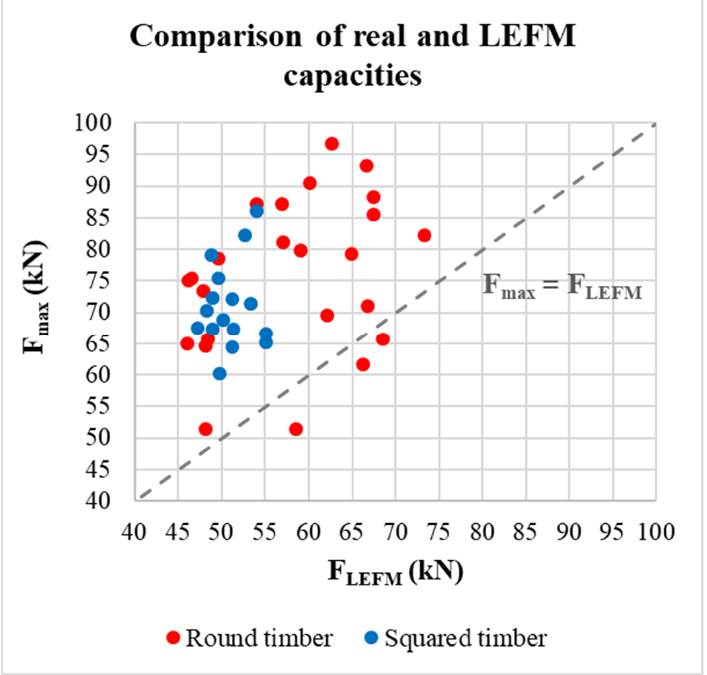
Figure 22. Comparison of the actual load-carrying capacities and the LEFM load-carrying capacities.